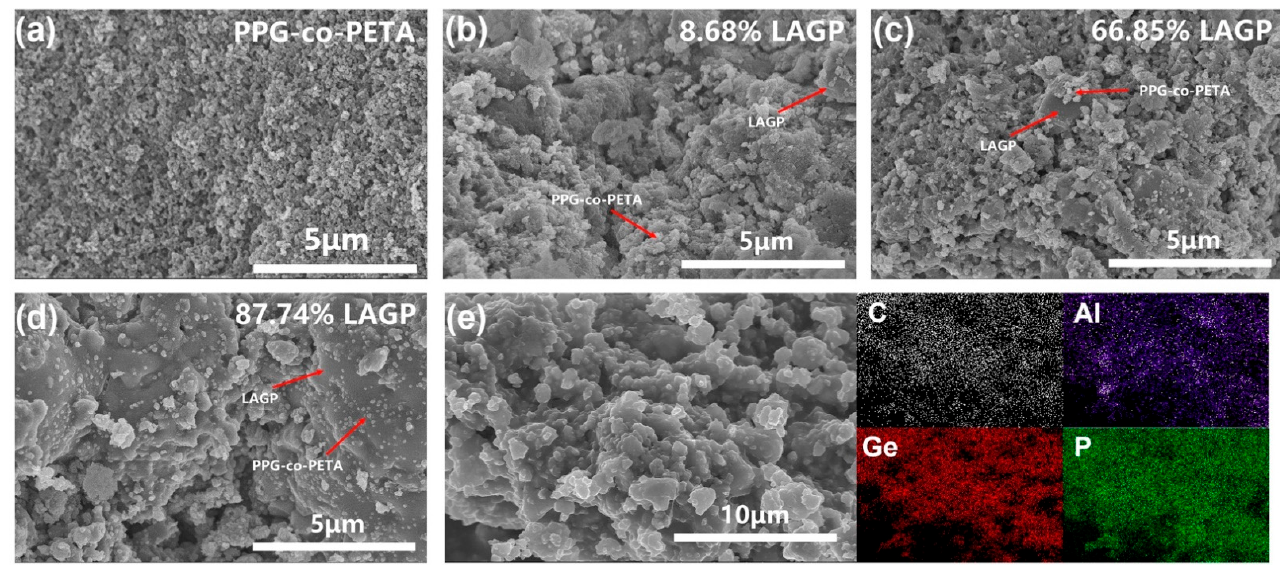
Figure 2. SEM images of ( a ) PPG-co-PETA and ( b – d ) composite PPG-co-PETA/LAGP with different content of LAGP. ( e ) Elemental mapping images of composite PPG-co-PETA/LAGP.